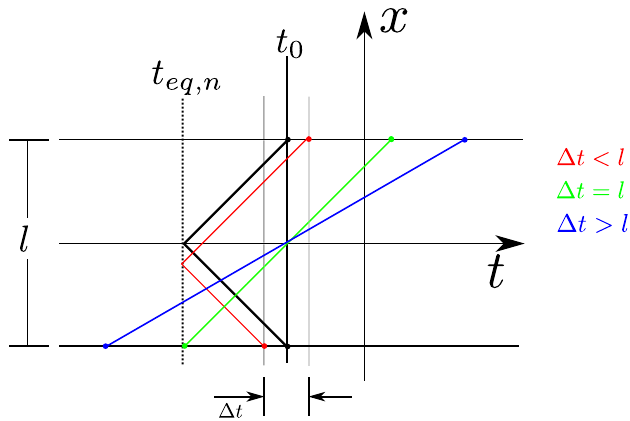
Figure 10 . Here we display the causal structure behind the nodes displayed in the bottom two panels of figure 9. The black wedge corresponds to the light cone which connects the points separated by a distance l . The red wedge does the same for points now also separated in time. Clearly they both touch the surface t 1 , a time for which the background passed though an equilibrium point. pt. This indicates that for correlators separated in length and displaced in time around a central time t will also take their thermal